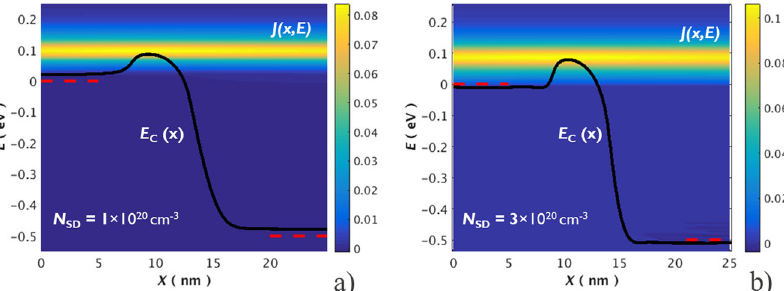
Fig. 6 Impact of source and drain doping on internal properties of a 2D MOSFET in off-state. Current spectrum J(E, x) (surface plot), as well as top conduction-band ( E C ) (-) edge along the channel direction, x , of a HfS 2 nMOS with L = 5 nm, in off-state. a For N SD = 1 × 10 20 cm − 3 . In this case, the lower N SD value is not suf fi cient to ensure degeneracy of the extension as can be seen at the source and drain-sides, where the conduction band is above the Fermi levels, E FS and E FD , respectively. Both Fermi levels are indicated by a red dashed line. b For N SD = 3 × 10 20 cm − 3 . The resulting narrower channel barrier allows for a larger part of the current spectrum to tunnel under the channel barrier (SDT). This effect is enhanced for larger N SD values as the effective-channel length is reduced. V D = 0.5